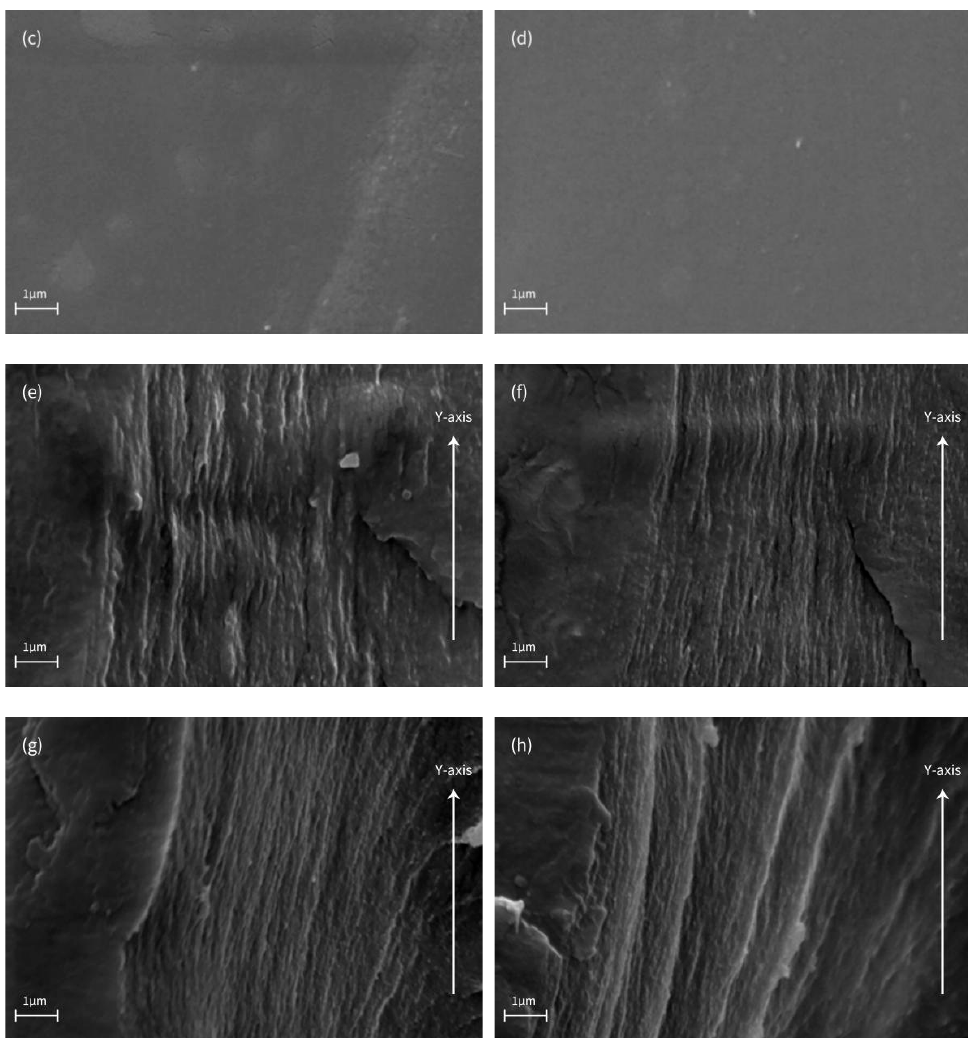
Figure 8. SEM image of top surface of ( a ) S0 film, ( b ) S1 film, ( c ) S2 film, ( d ) S3 film, and cross section of ( e ) S0 film, ( f ) S1 film, ( g ) S2 film, ( h ) S3 film.